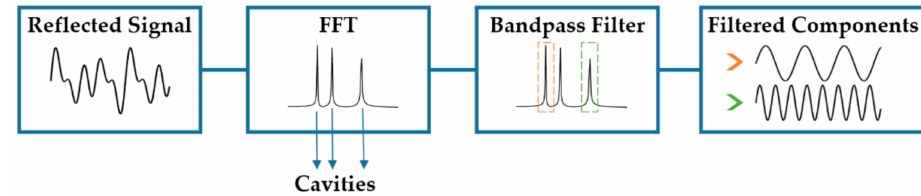
Figure 8. Signal processing steps to identify and separate each component of the reflection spectrum.